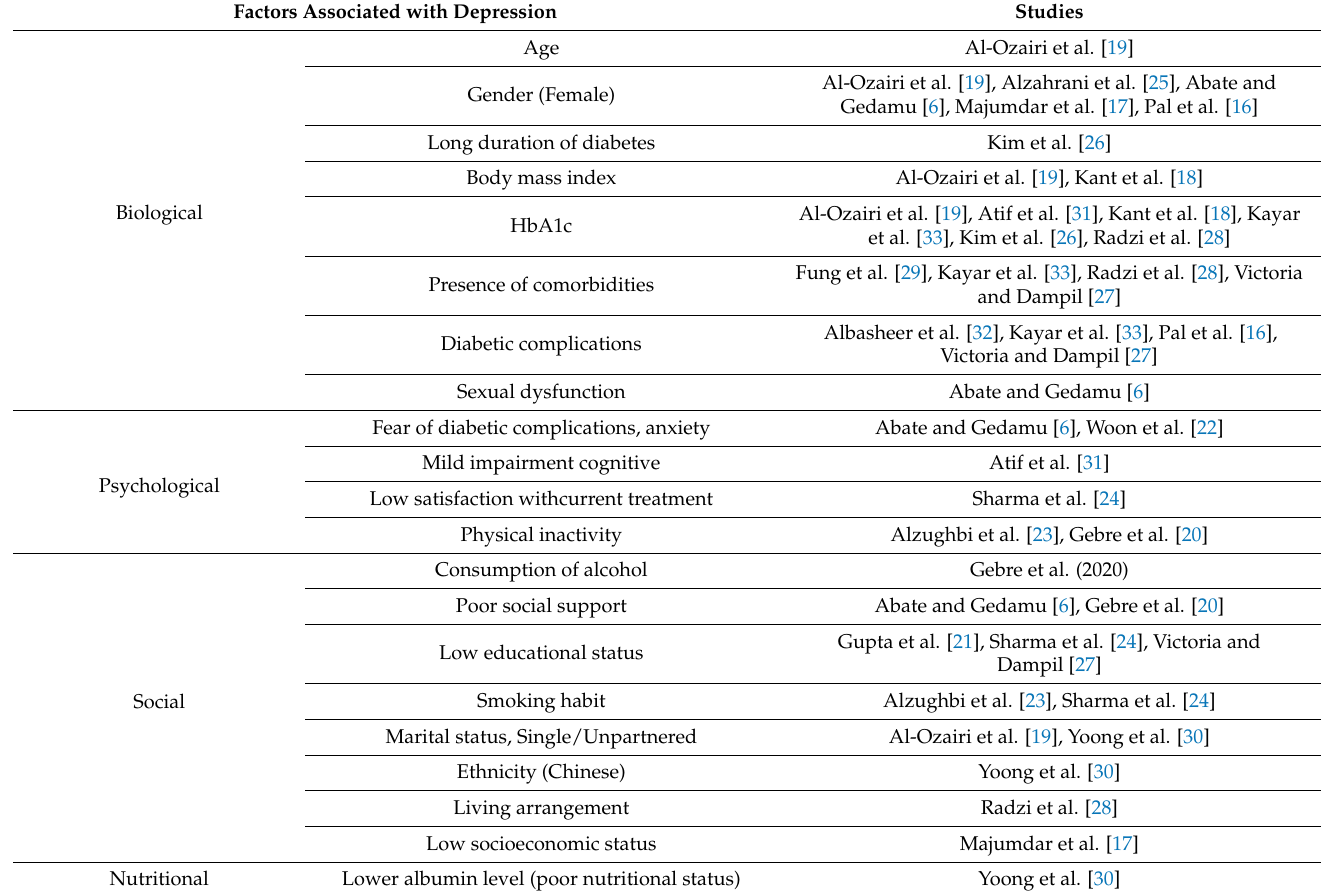
Table 3. Factors associated with depression in the included